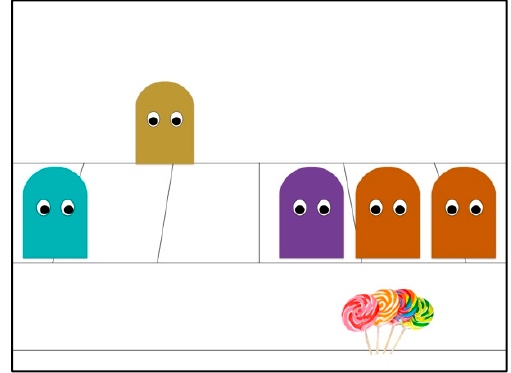
Figure 4. Exclusion scene outcome with neutral character.